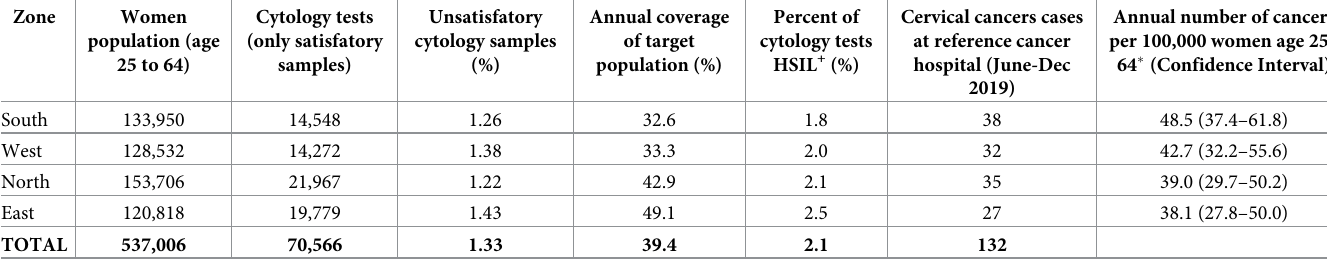
Table 2. Screening program indicators among women aged 25–64, by urban residential zone of Manaus, Brazil.